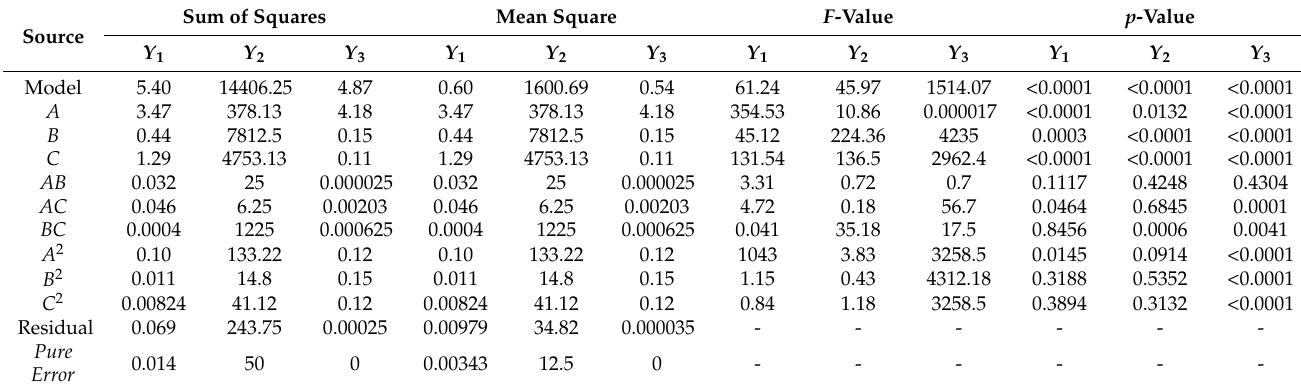
Table 6. ANOVA with the regression model of different response